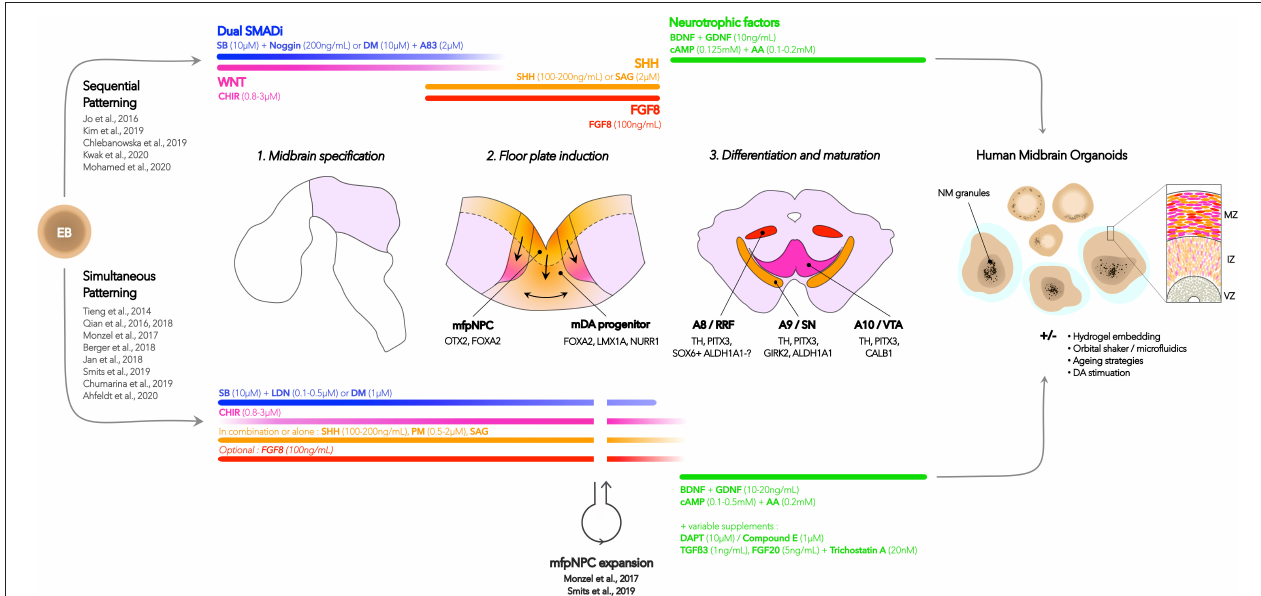
FIGURE 1 | Summarized hMO differentiation strategies. hMO differentiation protocols aim at reproducing essential dynamics of in vivo human midbrain development, which are represented by the drawings in the middle section: (1) midbrain specification using dual SMAD inhibition and WNT modulation; (2) midbrain floor plate (mfp) induction through modulation of SHH and FGF8, and (3) differentiation and maturation of midbrain dopaminergic neurons using neurotrophic factors (see Table 1 for details in hMO models of PD). Each step is associated with the generation of cell types that can be identified in vivo and in hMO models using the mentioned markers. Starting from hiPSC-derived embryonic bodies (EB), the described protocols have either relied on the use of sequential or simultaneous patterning strategies, represented as the top and bottom branches, respectively. Optional modifications to the protocol include expansion of mfpNeural Progenitor Cells (mfpNPC), hydrogel embedding, use of orbital shakers or microfluidics devices, aging strategies, and DA treatment. The generated hMO typically contain mDA neurons expressing markers of A9 and A10 terminal differentiation, and long-term cultures may favor the apparition of neuromelanin granules, which can be enhanced through DA stimulation. Features of floor plate organization in ventricle, intermediate, and mantle zones (VS, IZ, MZ) may also be revealed using markers of mDA progenitors ( 65). This organization is particularly evident in hydrogel-embedded organoids, as this process favors apico-basal polarization. SB, SB431542; DM, dorsomorphin; CHIR, CHIR99021; A83, A-83-01; SHH, sonic hedgehog; SAG, smoothened agonist; FGF8: fibroblast derived growth factor 8; BDNF/GDNF, brain/glial-derived neurotrophic factor; AA, ascorbic acid; cAMP, cyclic AMP; LDN, LDN193189; PM, purmorphamine; TGFß3, Transforming growth factor beta 3; FGF20, fibroblast derived growth factor